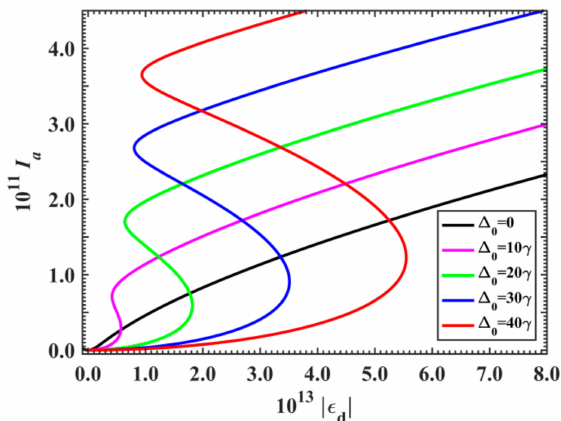
Figure 4. Curves of the mean intracavity photon number versus the intensity of the pump field under the condition with di ff erent detuning between the cavity mode-pump field, where γ 13 = γ 12 = γ 14 = γ ,